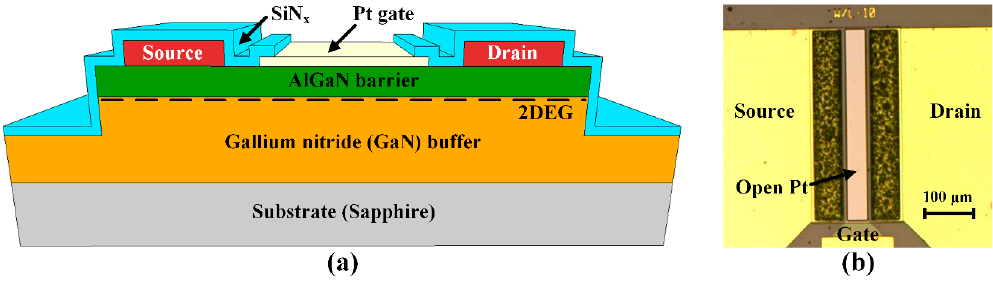
Figure 1. Schematic representation ( a ) and top view ( b ) of fabricated Pt-AlGaN/GaN HEMT H 2 S